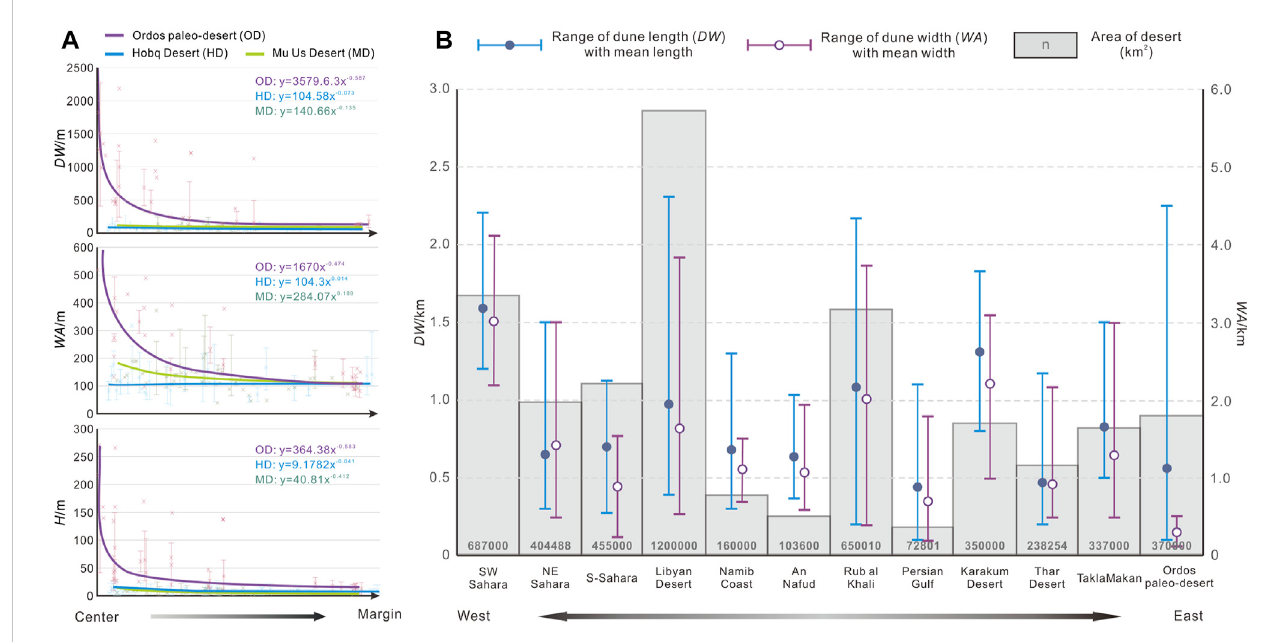
FIGURE 6 (A) Comparison graph of dune wavelength ( DW ), dune wave width ( WA ) and dune height ( H ) among the paleo-desert, Hobq and Mu Us Deserts in the Ordos Basin. (B) Comparison graph of area, DW and WA between the paleo-desert in the Ordos Basin and the global modern typical dune fi elds. All the statistical dunes are simple and compound crescentic